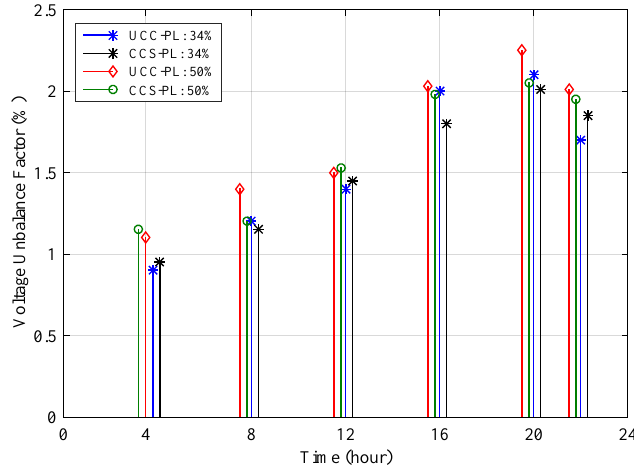
Figure 13. Voltage unbalances (%) at a load bus R15 in